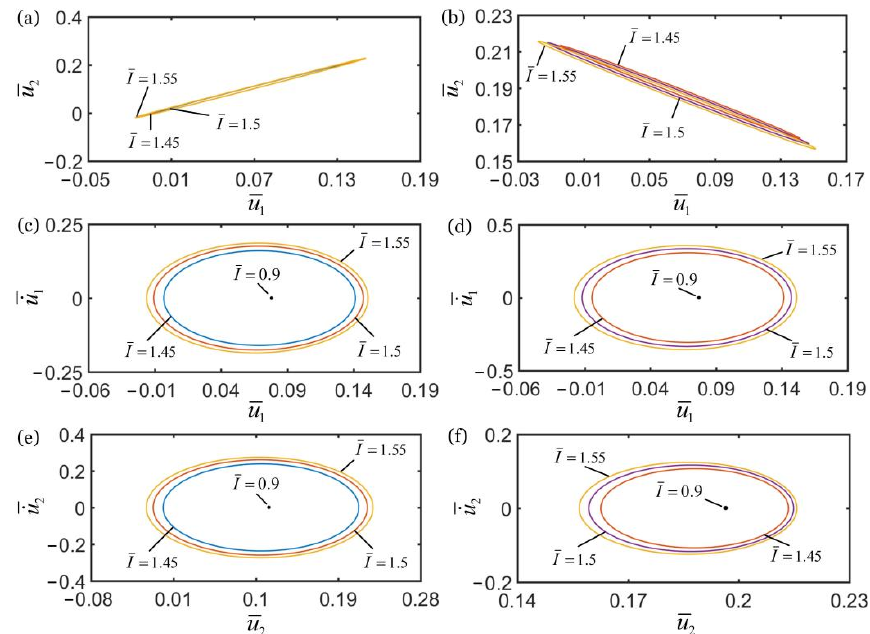
Figure 10. The effect of light intensity I on self-oscillations of the two coupled oscillators. ( a ) Domain of attraction, and ( c , e ) limit cycles for in-phase regime of k 2 = 16. ( b ) Domain of attraction, and ( d , f ) limit cycles for anti-phase regime of k 2 = 4.5. In the computation, the other geometric and material parameters are given in Table 2. With the increase of I , the amplitudes of self-oscillations of two coupled oscillators increase.